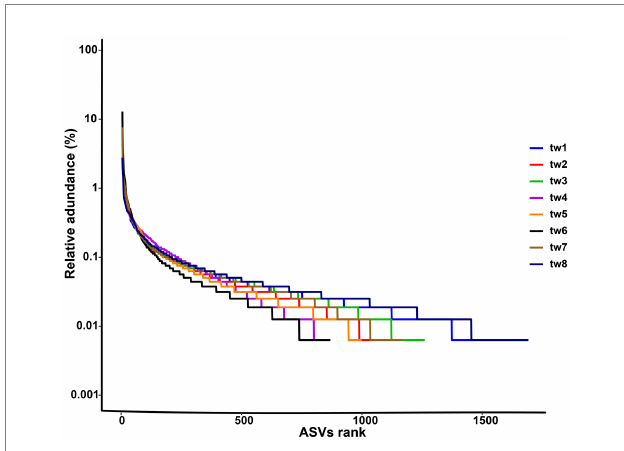
FIGURE 2 Rank abundance curve of each samples. The sample ids for the filter paper are tw1 through tw8.